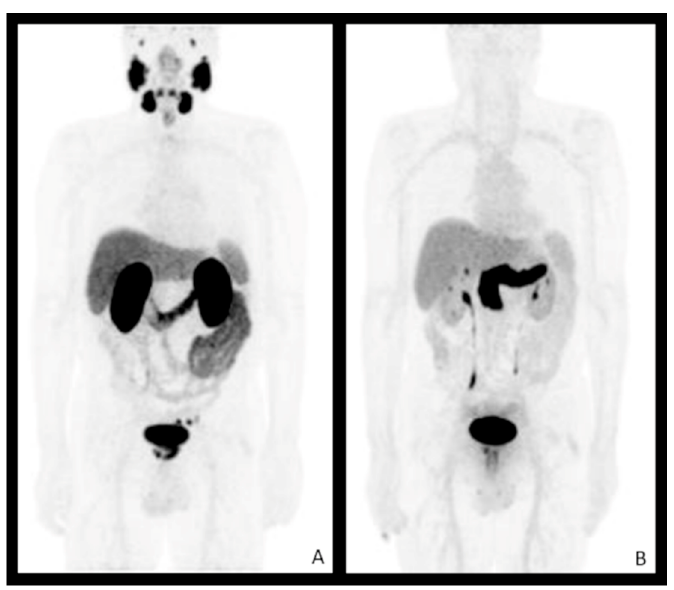
Figure 1. Physiological biodistribution of 68 Ga-PSMA ( A ) and 68 Ga-DOTA-RM2 ( B ) in patient n. 3. 68 Ga-PSMA PET detected intra-prostatic lesions in all patients, while 68 Ga-DOTA- RM2 PET identified the intraprostatic disease in 18/19 patients. Additionally, in 2/22 pa- tients 68 Ga-PSMA PET also detected seminal vesicles uptake. The specific sites of intra- prostatic 68 Ga-PSMA and 68 Ga-DOTA-RM2 uptake are reported in Table 2. Table 2. TNM findings of 68 Ga-PSMA, 68 Ga-RM PET/MRI and histological validation.